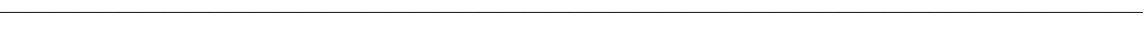
Fig. 2. Stratigraphic position and microfacies types of the buildup at Whitman(cid:146)s Hill. A , position of the studied interval within the section, modified from Ray et al. (2013); PS, parasequence; SB/TS, sequence boundary/transgressive surface; SMSS, surface of maximum sediment starvation; MFS, maximum flooding surface; SFR, surface of forced regression; ETST, early transgressive systems tract; LTST, late transgressive systems tract; HST, highstand systems tract; FSST, falling stage systems tract. B , main lithological units marked on the buildup photograph. C , distribution of facies types and of samples presented in D(cid:150)M. D(cid:150)H , coral bafflestone (facies IV): D, thin section, arrows indicate stromatactis -like structures; E, polished slab; D, E, scale bar 1 cm; F, sponge spicule; G, close-up of a stromatactis -like structure; G, H, scale bar 500 (cid:181)m; H, recrystallized gastropod with Rothpletzella coating, scale bar 200 (cid:181)m. I , J , oncoidal rudstone (facies II), polished slabs, scale bars I (cid:150) 500 (cid:181)m, J (cid:150) 1 cm. K(cid:150)M , SEM photographs of polished slabs, etched with 1N HCl for 30 s and sputter-coated with gold: K, L, sample shown in J; K, ? Girvanella floating in micritic matrix, scale bar 20 (cid:181)m; L, porostromate oncoid, scale bar 100 (cid:181)m; M, allochthonous micrite in the area marked with a dashed line in E, scale bar 500